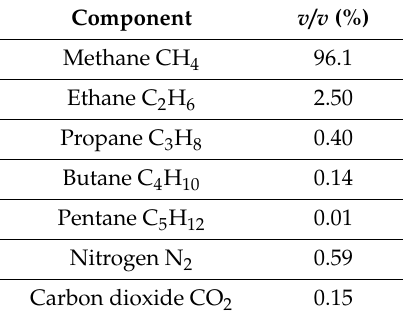
Table 4. Compressed natural gas (CNG) composition.